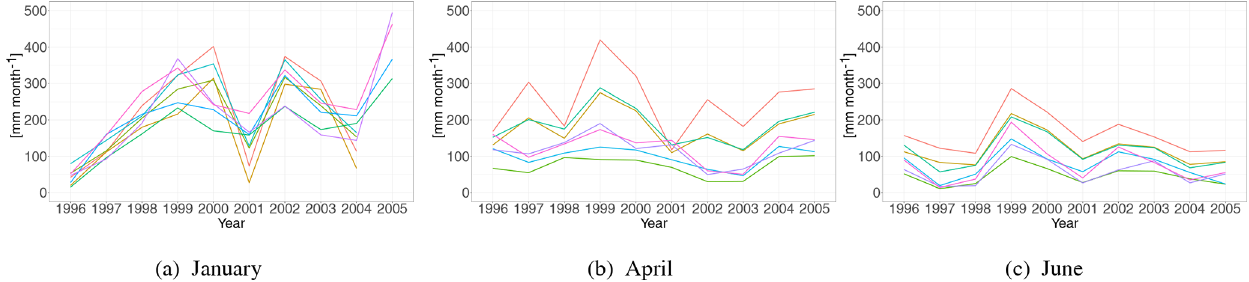
Figure 3. Annual series of monthly runoff for January, April and June for the 7 catchments in Fig. 2a. The time series for January and April are less parallel compared to the time series for June and to the annual runoff (Fig. 2b). This suggests that the datasets from January and April represent a more hydrologically spatially unstable